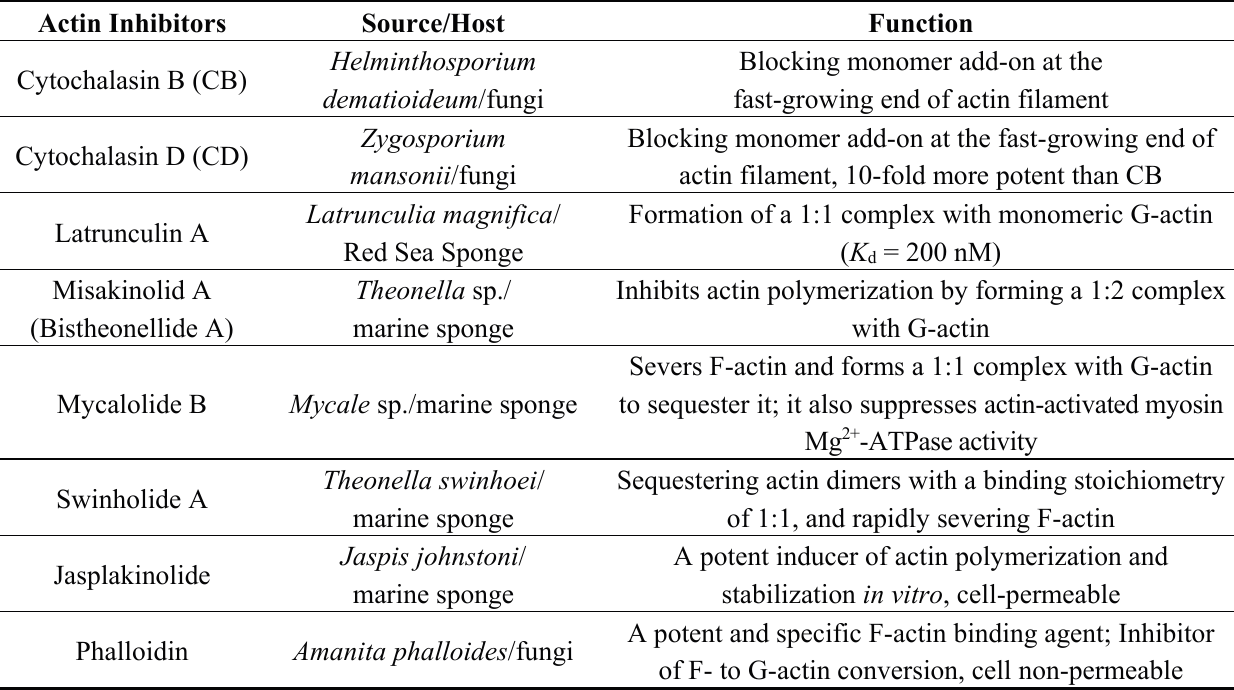
Table 1. The sources and functions of various actin